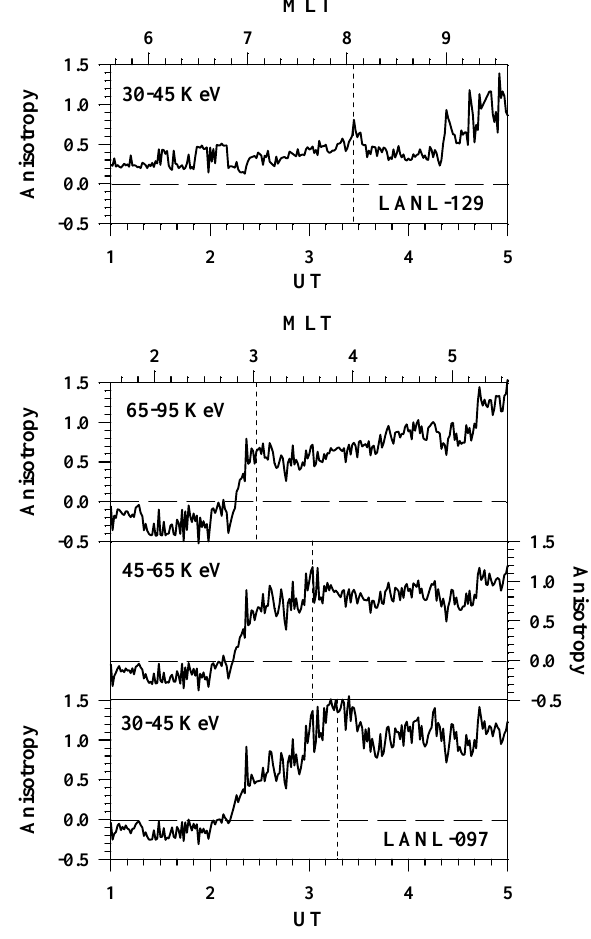
Fig. 4. Anisotropy of differential fluxes for three energy channels of the LANL-097 satellite and for the lower energy channel of the LANL-129